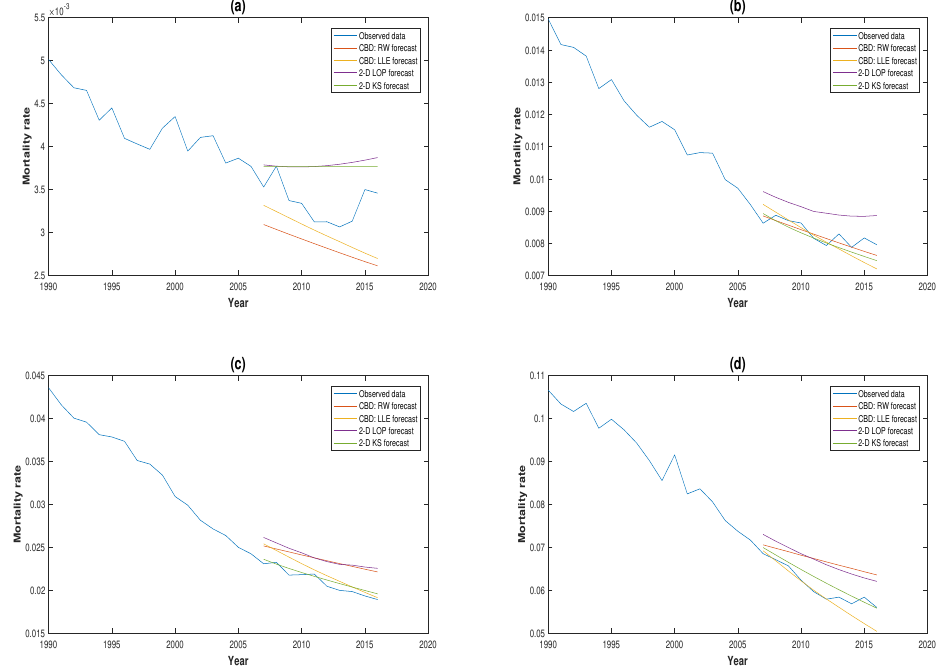
Figure 4. Ten-year-ahead forecast from 2007–2016 for GB males aged ( a ) 50, ( b ) 60, ( c ) 70 and ( d ) 80 based on mortality data since